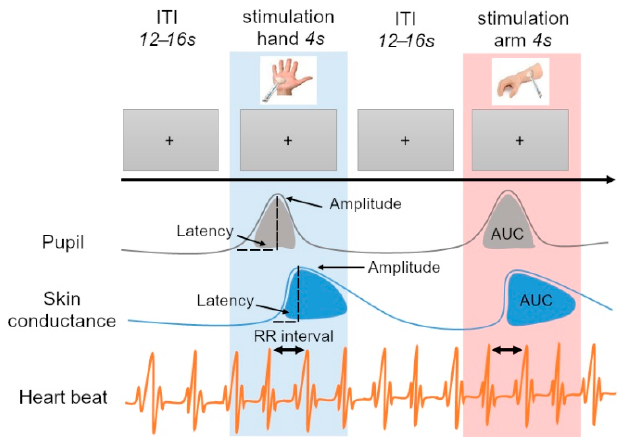
Figure 1. Experimental Procedure. During the experiment, pupil size, skin conductance and cardiac frequency were recorded while 10 stroking stimulations on the arm and 10 on the palm of the hand were performed by the experimenter. The stimulation phase lasted 4 s. It was preceded by a 4 s pre- stimulation phase, considered as baseline for skin conductance and cardiac frequency, and the last 250 ms of which were used to calculate the pupil baseline values. The inter-trial interval (ITI) lasted between 12 and 16 s.